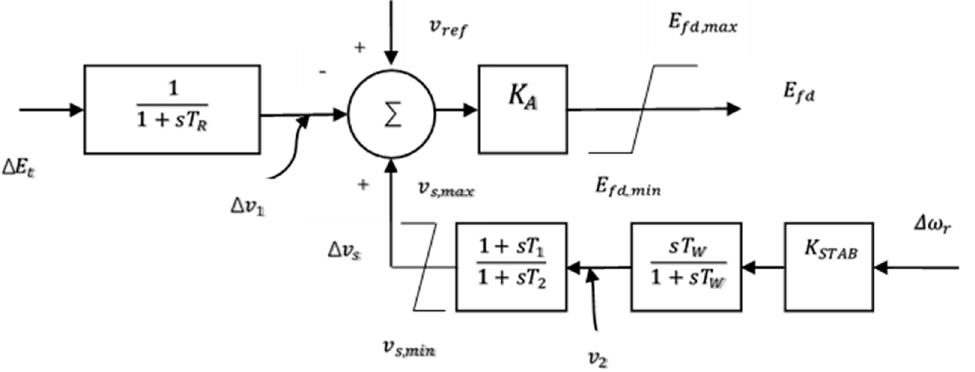
Figure 2. Excitation system with a PSS and AVR.